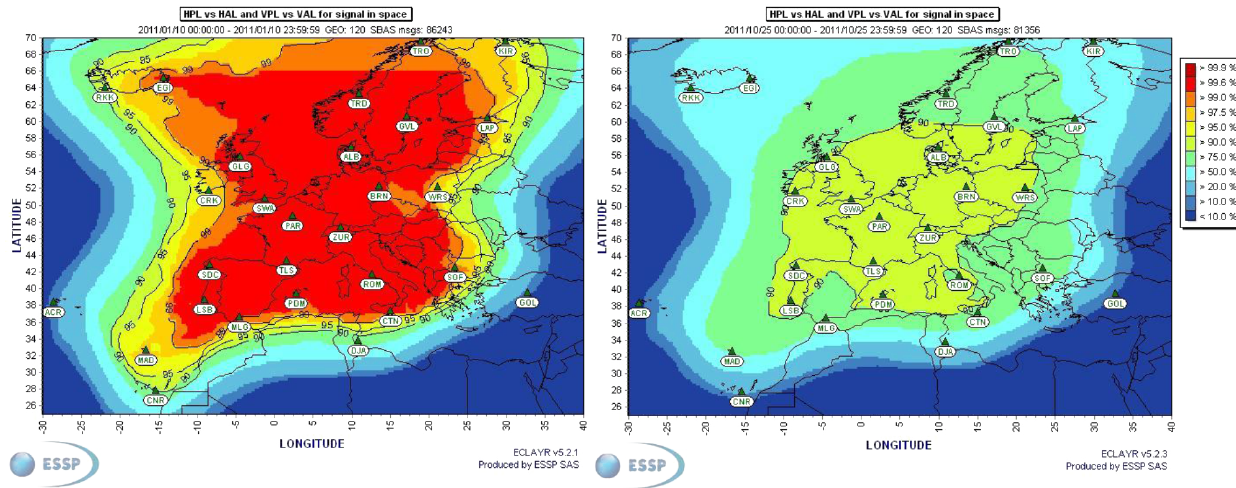
Figure 2. The EGNOS APV-1 availability maps for DOYs 010 (left) and 298 (right) in 2011.